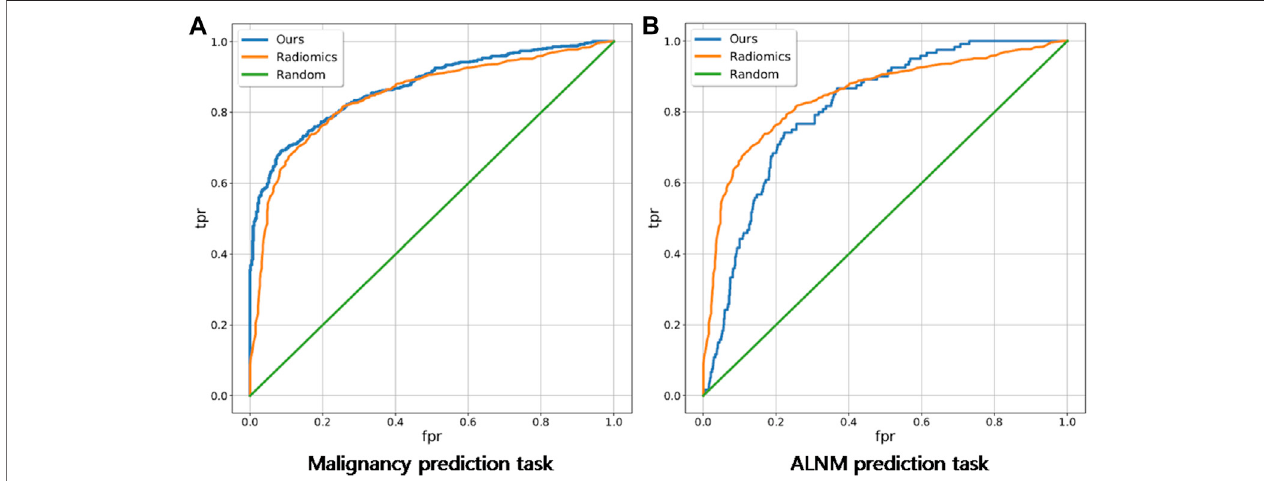
FIGURE3| Receiveroperatingcharacteristiccurvesofourdeep-learningmodelandatraditionalradiomicsmodelonmalignancypredictionandALNMprediction. (A) and ALNM prediction (B) tasks.